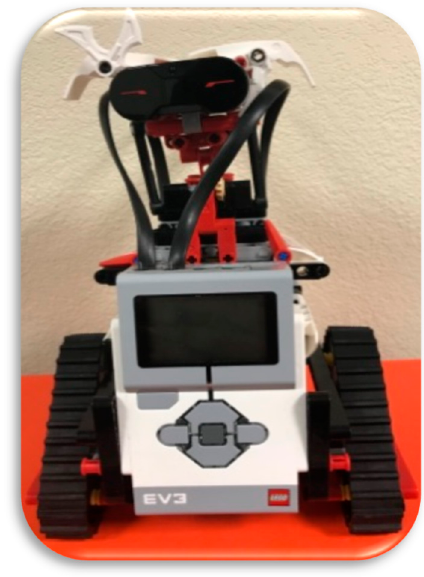
Figure 1. Lego Mindstorms EV3 robot.